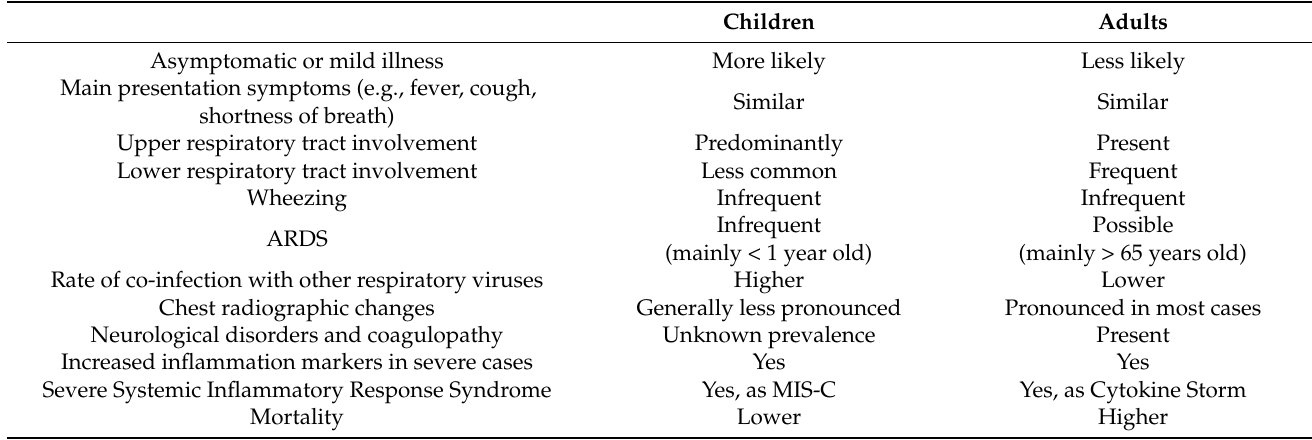
Table 1. Clinical characteristics of SARS-CoV-2 infection in children and adults.